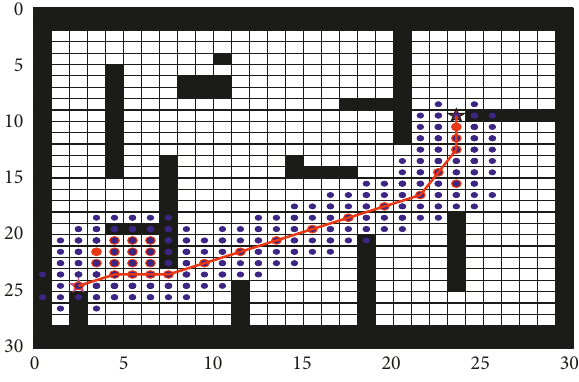
Figure 6: 5 ∗ 5 Search neighborhood planning result.